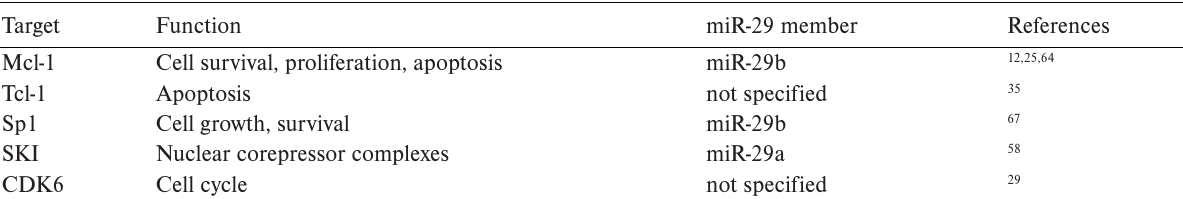
Table 2. Oncogenes as miR-29 targets in hematological